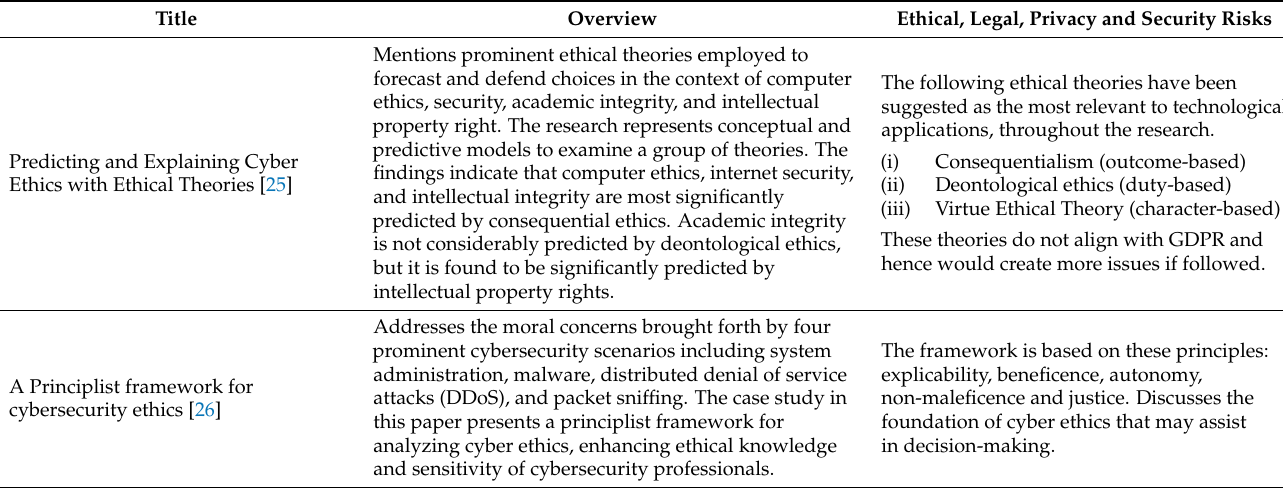
Table 1. Cyber ethics: legal, privacy, and security